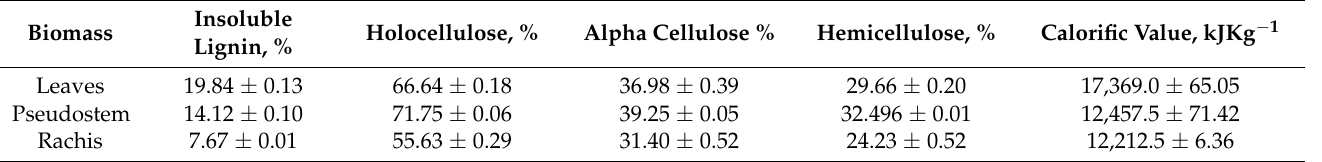
Table 2. Structural characterization of biomass from the banana